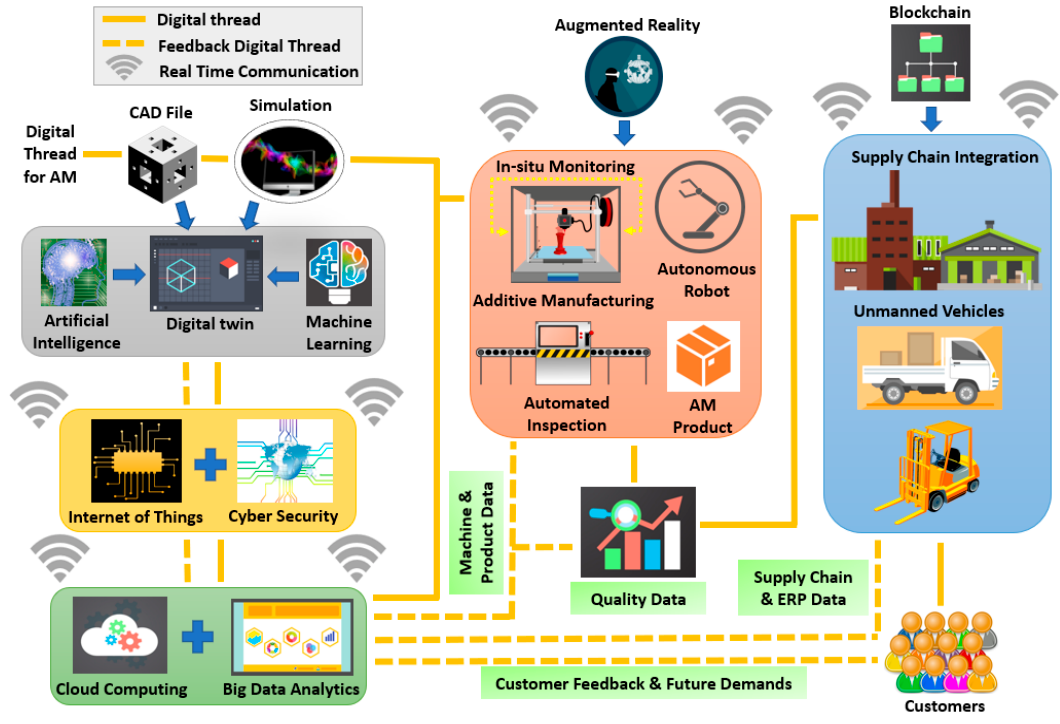
Figure 9. Digital thread for AM.